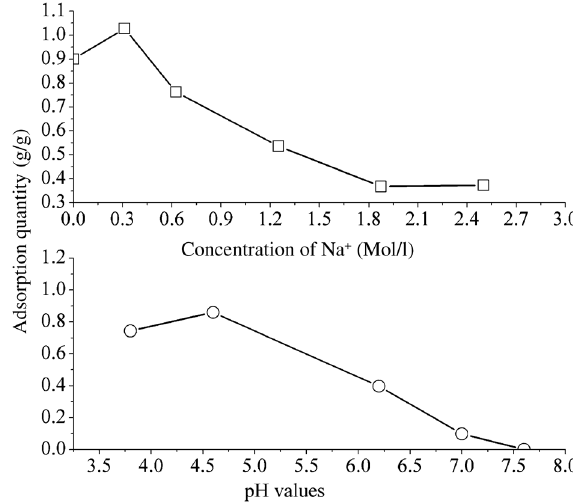
Figure 1 Effect of ionic strength and pH values on